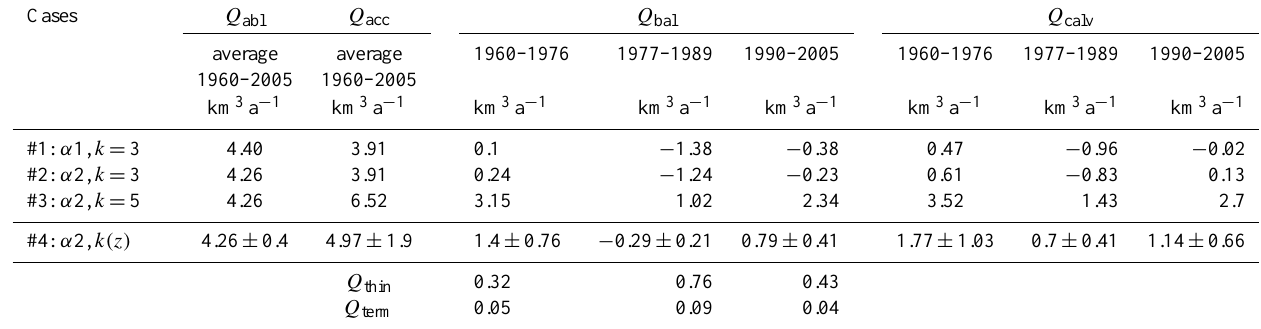
Table 2. Summary of modeled ice fluxes through Glaciar San Rafael, 1960–2005. Scenarios used in model runs: α 1=ablation flux using Eq. (1a) only; α 2=ablation flux calculated using Eqs. (1a) and (1b); k(z) =enhancement factor used in Eq. (4). Q calv is calculated as in Eq. (7) as the sum of Q thin , Q bal and Q term . Q thin and Q term did not vary from case to case.